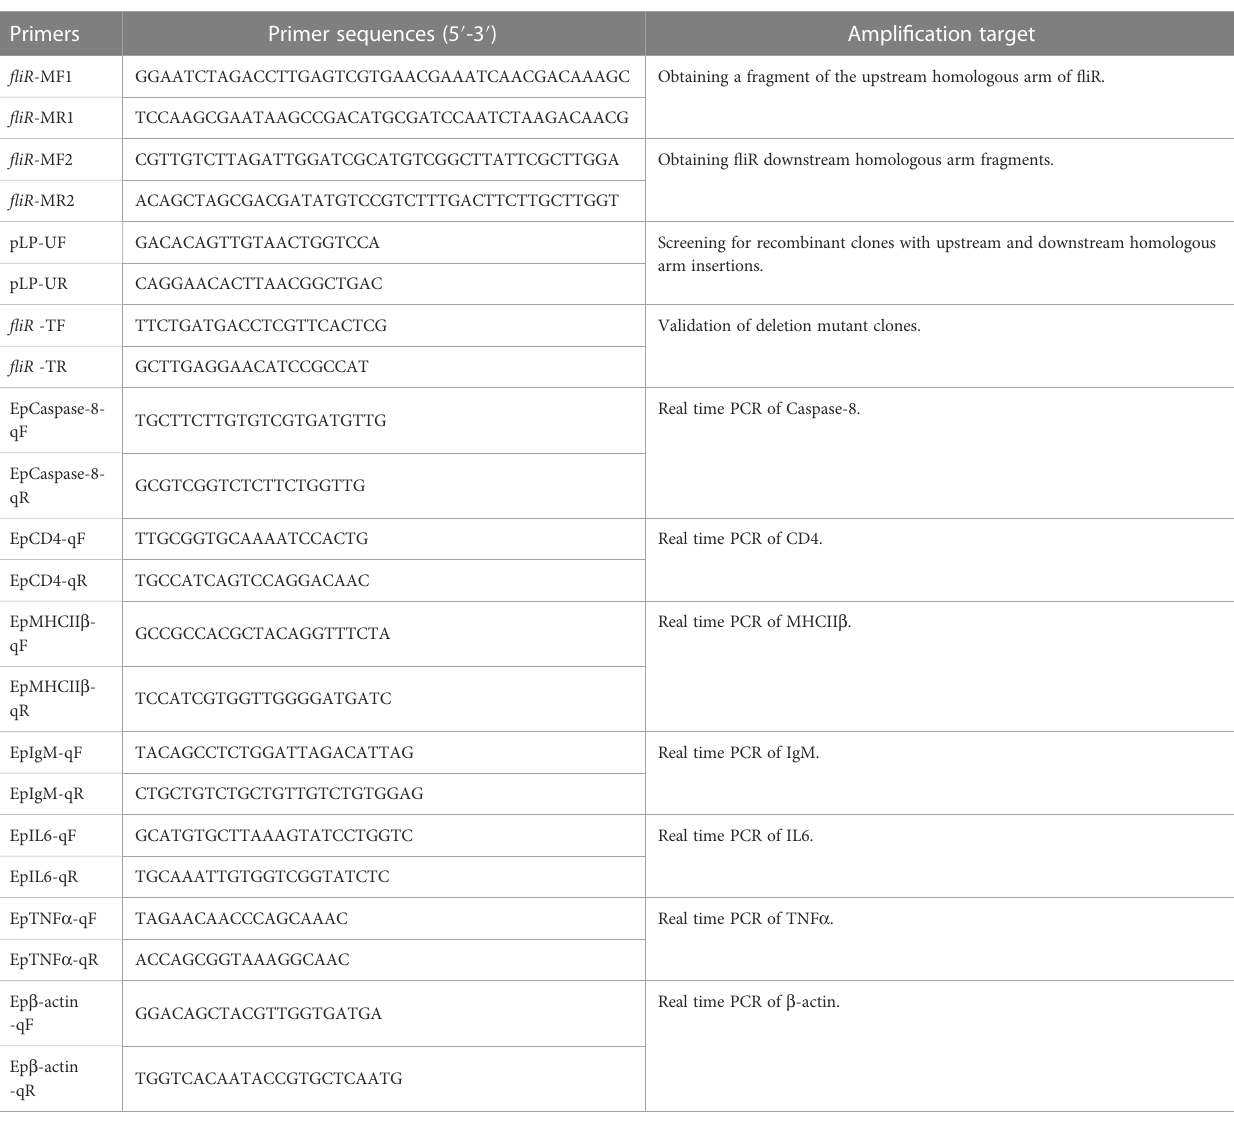
TABLE 2 Experiment of